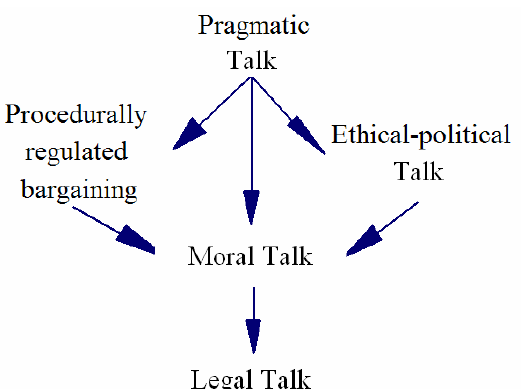
Figure 1 : Habermas's procedural model of rational public interest-formation 1